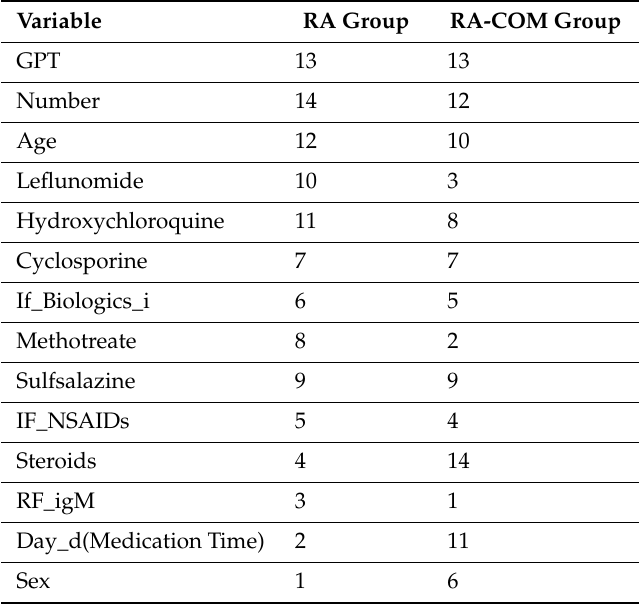
Table 5. Ranking of variables for the RA and RA-COM